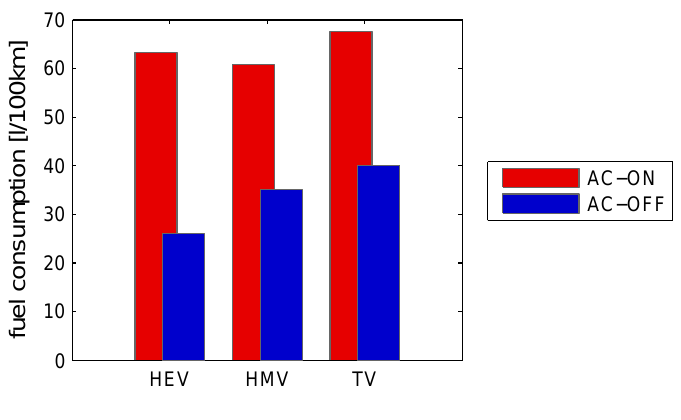
Figure 16. Fuel consumption of the HEV, HMV and TV with the air cooling system turned off (blue bars) and on (red bars) in the city of Taranto driving